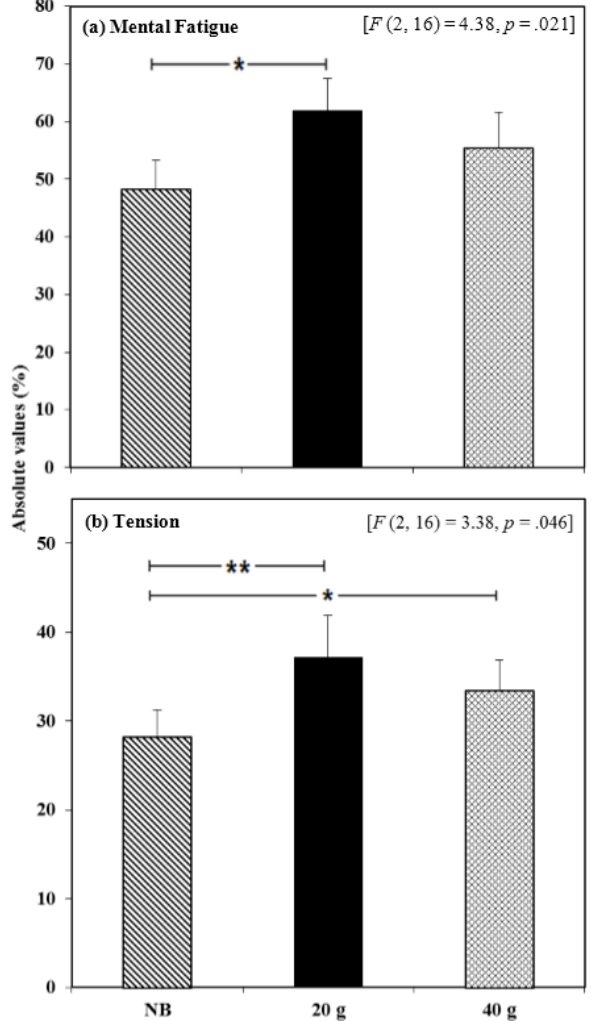
Figure 4. The effects of consuming breakfast cereal (20 g or 40 g) or no breakfast (NB)